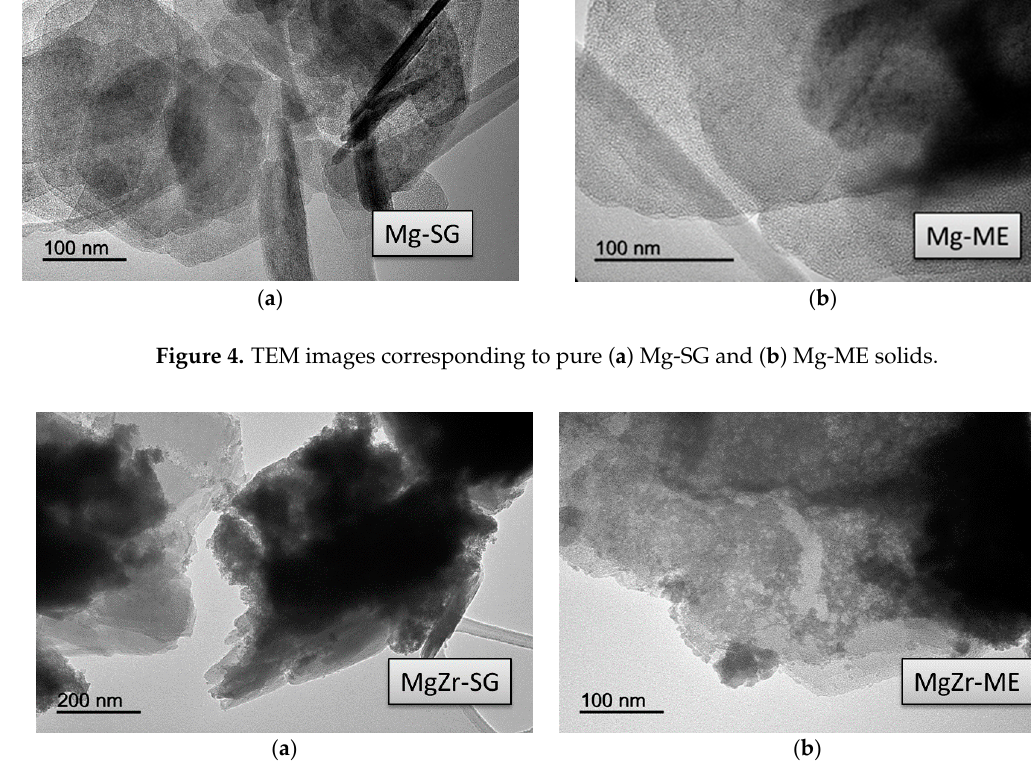
Figure 5. TEM images corresponding to (a) MgZr-SG and (b) MgZr-ME solids.